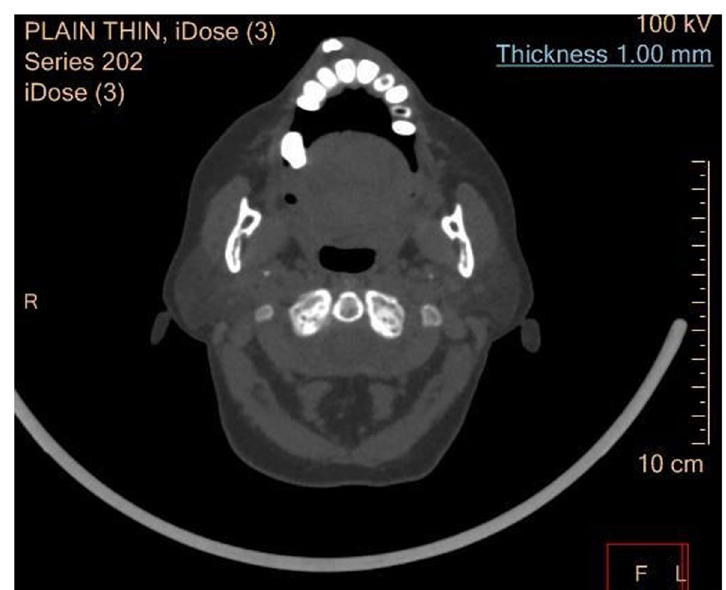
Fig. 3 Axial CT image showing embedded radio-dense foreign body in soft tissue of upper lip